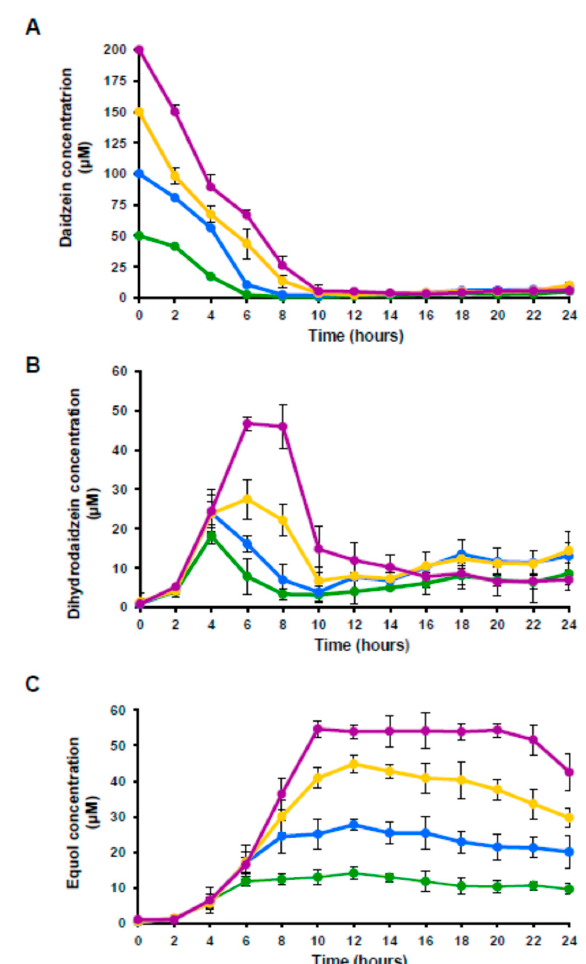
Figure 2. Evolution of daidzein ( A ), dihydrodaidzein ( B ), and equol ( C ) in cultures of A. equolifaciens DSM19450 T supplemented with 50 μ M (green), 100 μ M (blue), 150 μ M (yellow) and 200 μ M (purple) of daidzein.